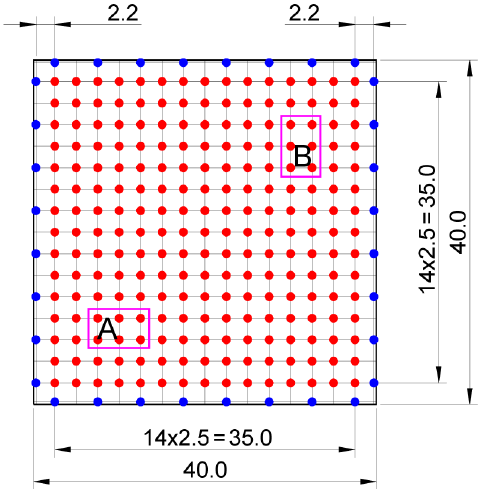
Fig. 13. Stiffness of the piles are different: area A with 20, 30 or 40% higher stiffness of piles; area B with 20, 30 or 40% lower stiffness of piles